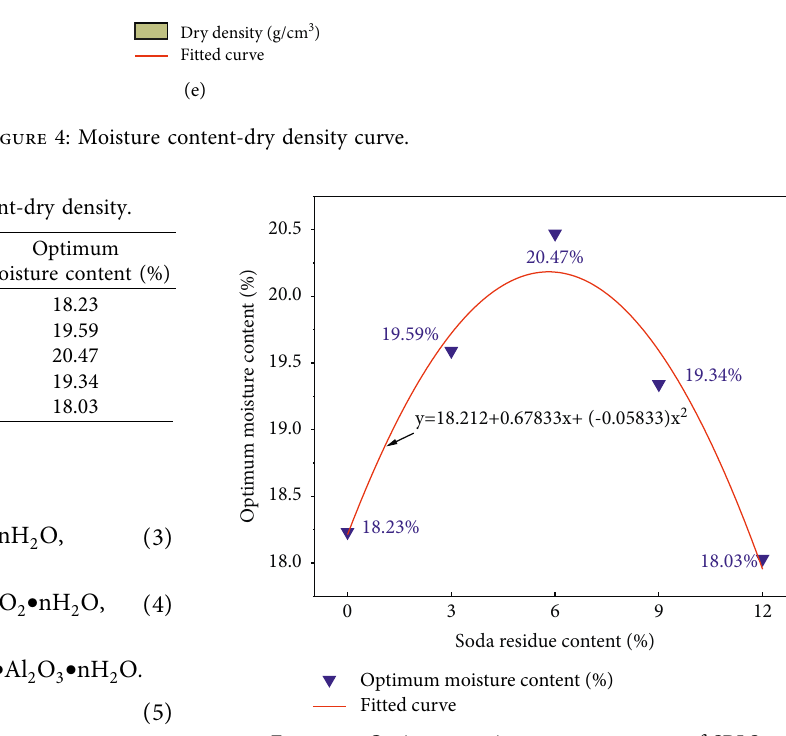
Figure 5: Optimum moisture content curve of